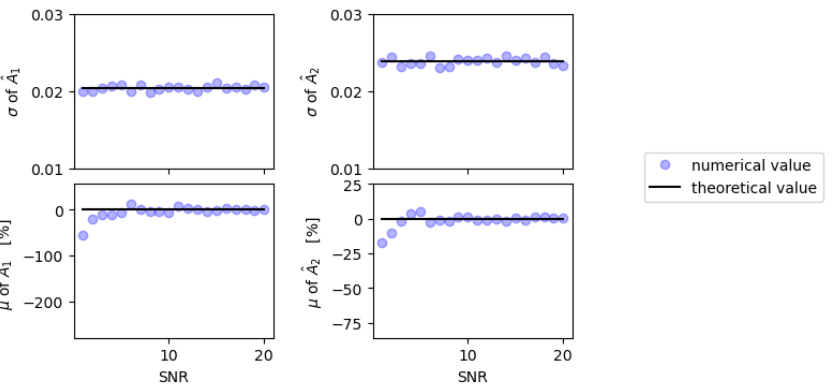
Figure 3. Bias and standard deviation of the quadrupole amplitudes A 1 ( left panel) and A 2 ( right panel). Theoretical predictions are drawn as continuous